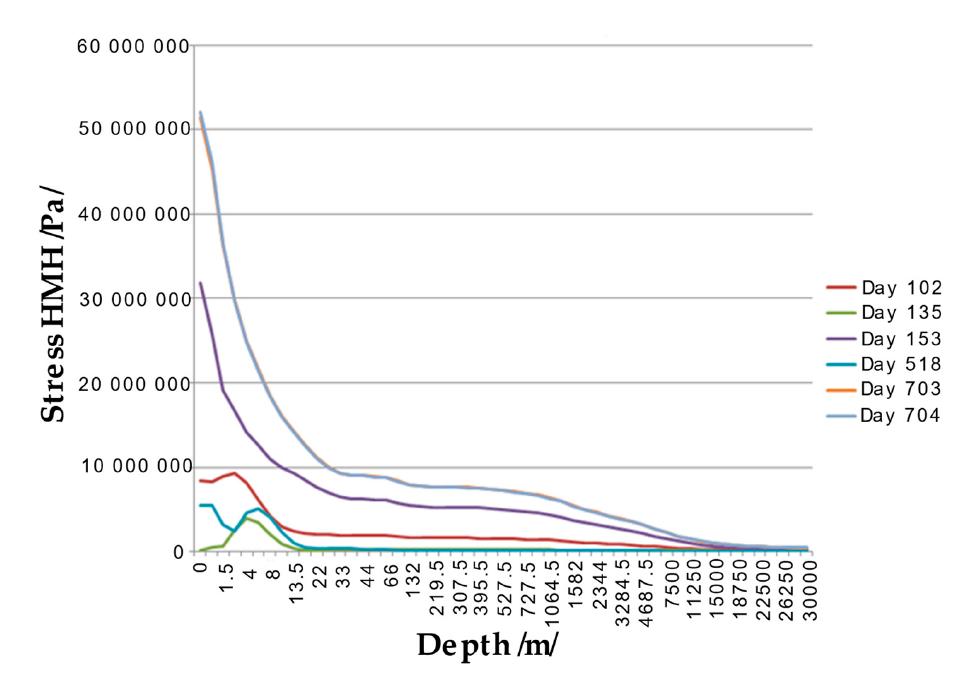
Figure 8. Plot of depth evolution of the equivalent von Mises stress (HMH) /Pa/ at the interface of sections 1 and 2 of Figure 3 ( φ = 0°).